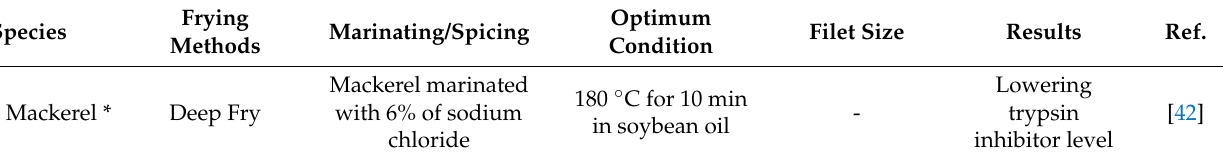
Table 2. Optimum condition for frying mackerel with marinade and